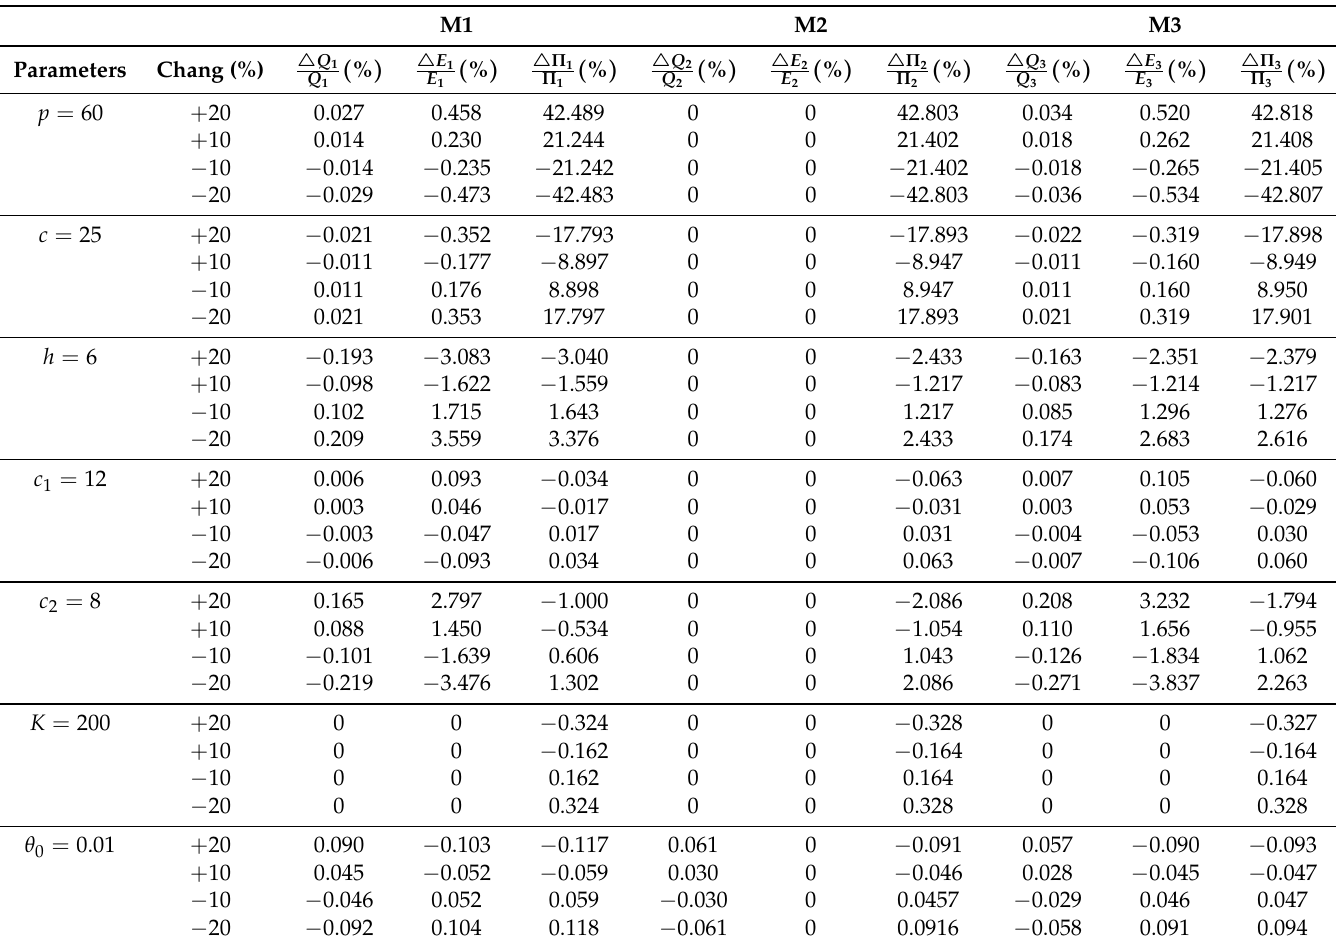
Table 1. Robustness results of the proposed